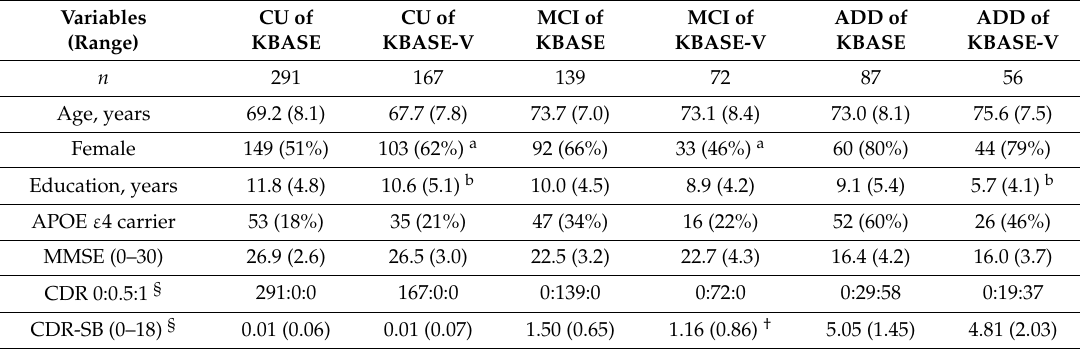
Table 2. Baseline characteristics of the KBASE and KBASE-V